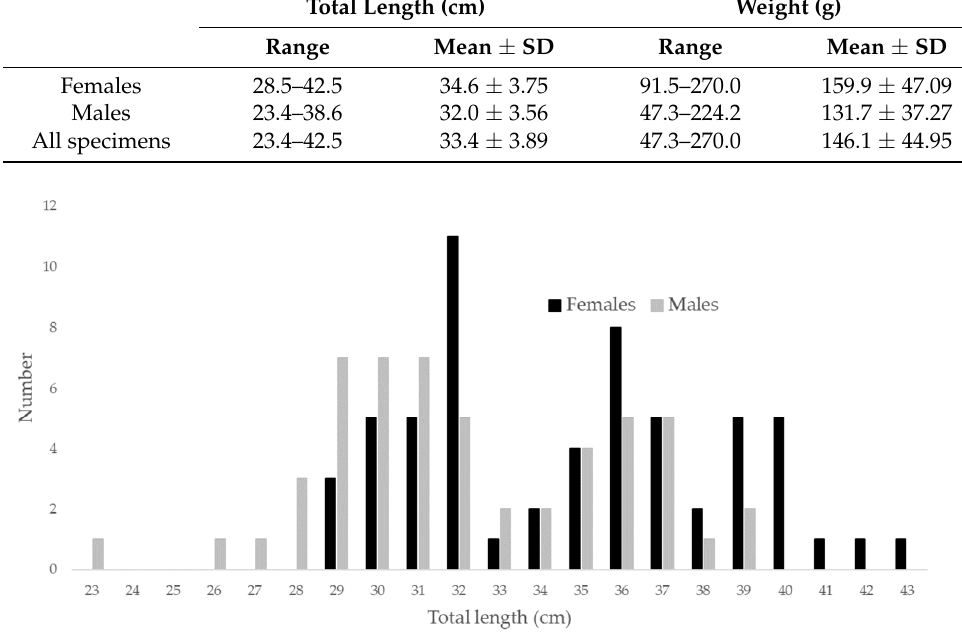
Figure 1. Length frequency distributions of the European barracuda, Sphyraena sphyraena , females and males in the eastern Adriatic.